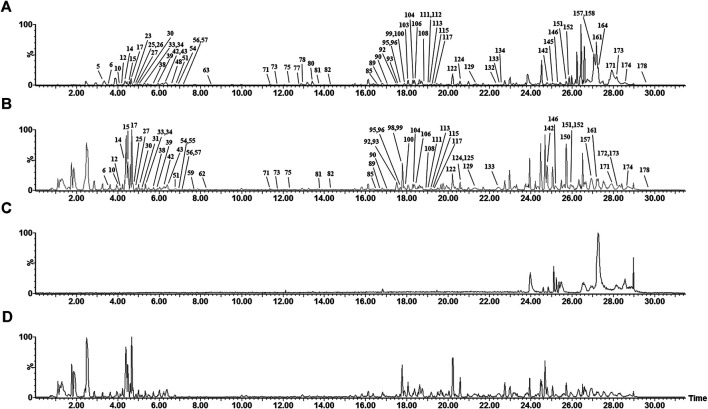
Representative base peak intensity (BPI) chromatograms of absorbed compounds after oral administration of WFC in negative mode (A) and in positive mode (B) by UHPLC-ESI-Q-TOF/MS; Representative base peak intensity (BPI) chromatograms of blank serum in negative mode (C) and in positive mode (D) by UHPLC-ESI-Q-TOF/MS.